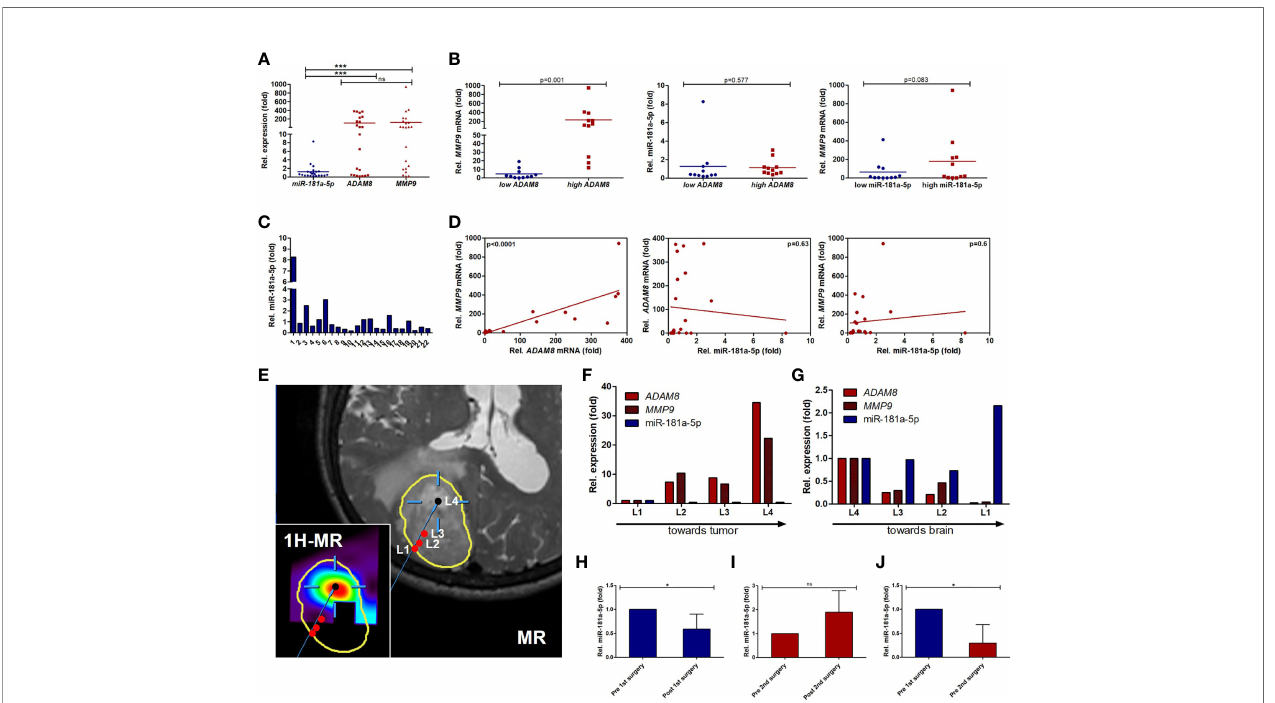
FIGURE 5 | Expression levels of ADAM8 and MMP9 , and miR-181a-5p in GBM tissue samples. (A) RT-qPCR results of GBM tissue samples (n=22, fold change normalized to 1) indicate a higher expression of ADAM8 (p-value: 0.0009) and MMP9 (p-value: 0.0002) than miR-181a-5p. (B) Dividing the RT-qPCR results and patient cohort into two groups (low/high ADAM8 or low/high miR-181a-5p expression) reveals a correlation of ADAM8 with MMP9 (left graph, p-value: 0.001) but no correlation of miR-181a-5p with ADAM8 (middle graph, p-value: 0.577) or MMP9 (right graph, p-value: 0.083) expression. (C) RT-qPCR results for miR-181a-5p expression of each GBM tissue sample. (D) ADAM8 and MMP9 are correlated in GBM tissue samples (p < 0.0001, n=22), whereas the inverse correlations of ADAM8 and miR-181a-5p and of miR-181a-5p and MMP9 are non-signi fi cant (p-values: 0.63 and 0.6, respectively). (E) T2-weighted magnetic resonance (MR) image showing a left parietal GBM (segmented in yellow, patient 25) as well as the co-registered choline/N-acetylaspartate (NAA) maps derived from 1H-MR spectroscopy, integrated into the neuronavigation system for navigated extraction of tissue samples (L1: tumor border, L2/L3: tumor, L4: tumor, Cho/NAA hotspot) magnetic resonance (heatmap for choline metabolite). Corresponding molecular analyses are shown in (F, G) (patient 25). RT-qPCR results of ADAM8 (red), MMP9 (tiled red), and miR-181a-5p (blue) in different tissue locations normalized to either L1 (F) or L4 (G) describing the direction of surgery. (H) In a pilot study, three GBM patients (Patient 9, 23, 24) were analyzed for their serum-EV miR-181a-5p expression via RT-qPCR. The serum was collected before and after the fi rst and second surgery. Interestingly, after fi rst surgical resection miR-181a-5p is less expressed in serum-EVs (p-value: 0.042). (I) After second surgery, miR-181a-5p shows a slight increase in serum-EVs (p-value: 0.08). (J) , miR-181a-5p is less detectable in serum-EVs prior to the second surgery compared to pre- fi rst surgery (p-value: 0.02; left graph). Results are shown in mean values +/- SD. Unpaired one-tailed students t test and Wilcoxon signed-rank test were applied to determine signi fi cance: ns, not signi fi cant, *p < 0.05, **p < 0.01, ***p <